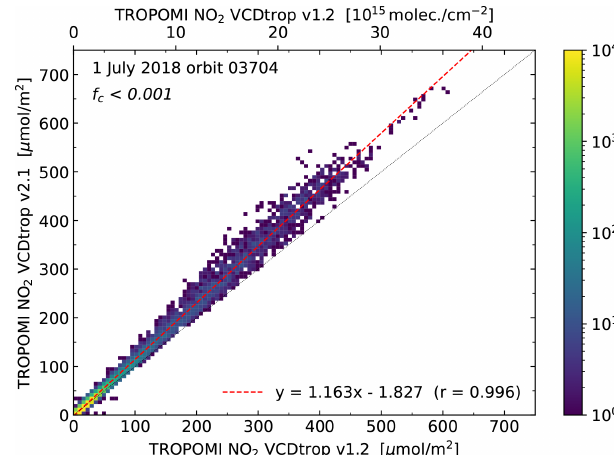
Figure 11. Comparison of the TROPOMI NO 2 tropospheric VCD of orbit 03704 of 1 July 2018, showing all ground pixels for which both the v1.2 and v2.1 cloud retrievals give zero cloud fraction, i.e. for which the surface albedo may have been adjusted and the tropospheric VCD was found to be positive. See the text for fur- ther details. The linear fit coefficients and correlation coefficient are given in the legend.